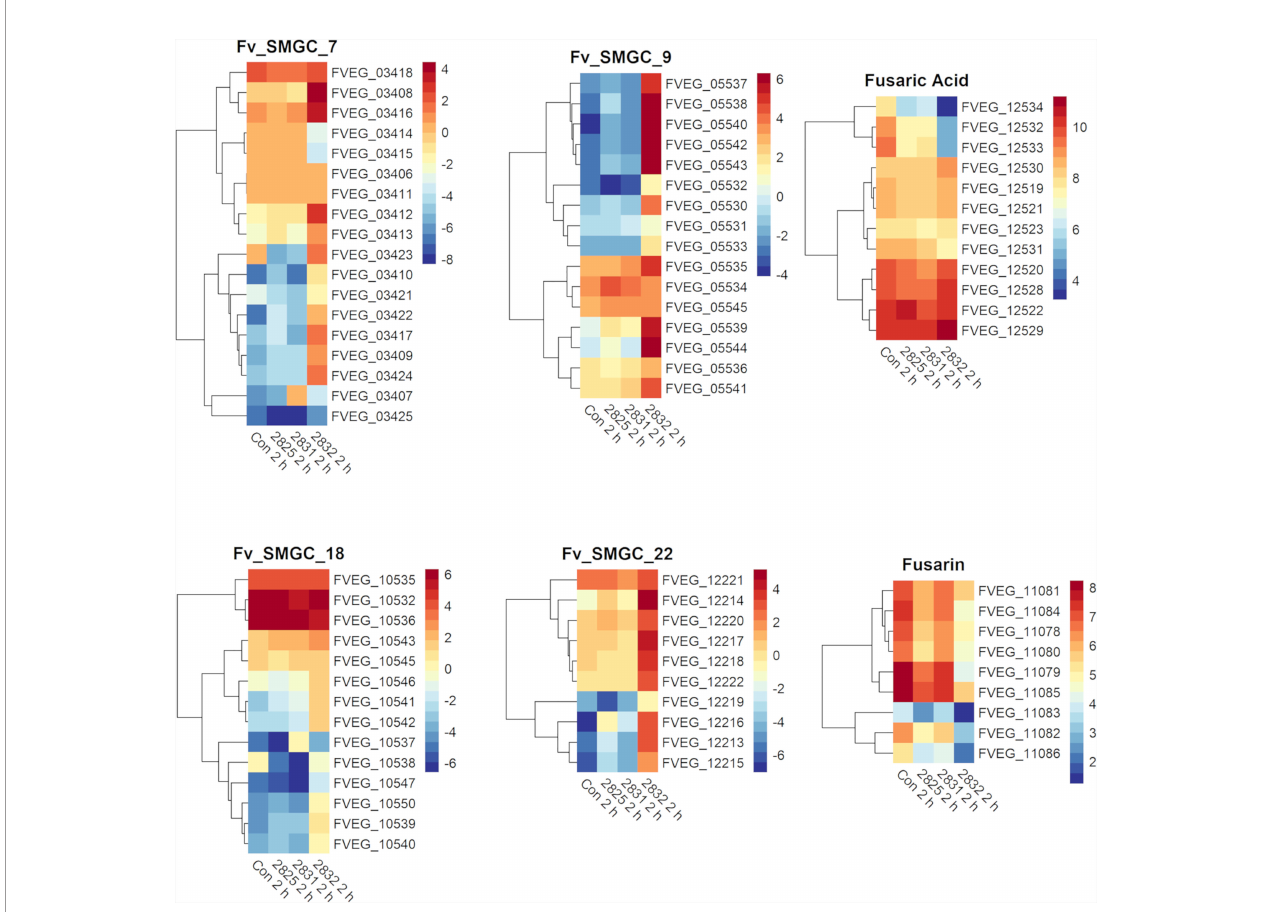
FIGURE 4 | SMGCs induced at 2 h after exposure to Streptomyces. Heat maps of F. verticillioides RPKM values of fusaric acid and fusarin clusters and SMGC 7, 9 18, and 22 at 2 h. RPKM values were logarithmically transformation before being visualized by R package “ pheatmaps ” . The scale bars represent these logarithmic values. The data are presented for the 2 h exposures with Streptomyces strains s2825, s2831, and s2832. The s2827 interaction is not re fl ected in this fi gure as no genes (except FVEG_03697) were differentially expressed with respect to secondary metabolism gene